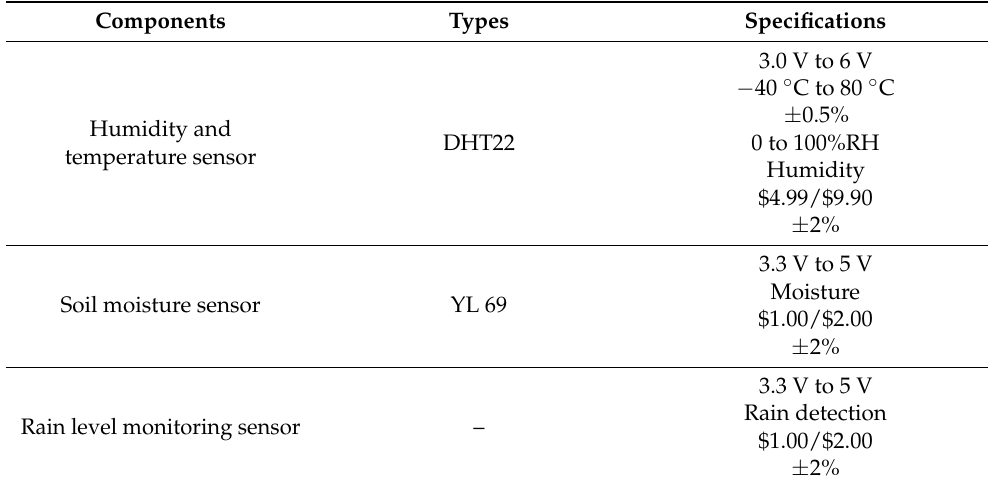
Table 2. Specifications of different components.